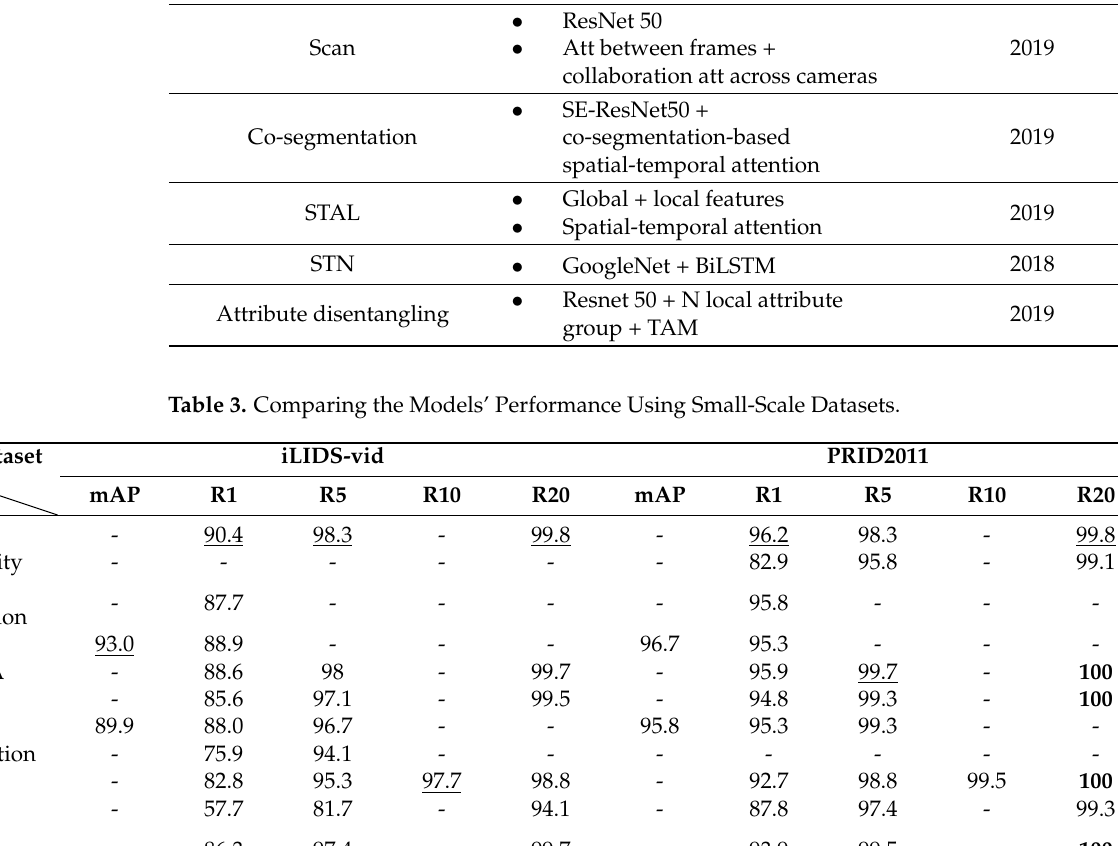
Table 4 presents a comparison of the performances when applied to large-scale datasets. Our model improves Rank1 by 0.9% relative to the best R1 (BICnet) on DukeMTMC- VideoReID and improves mAP by 2.1% relative to the best MAP (BICnet) on MARS after